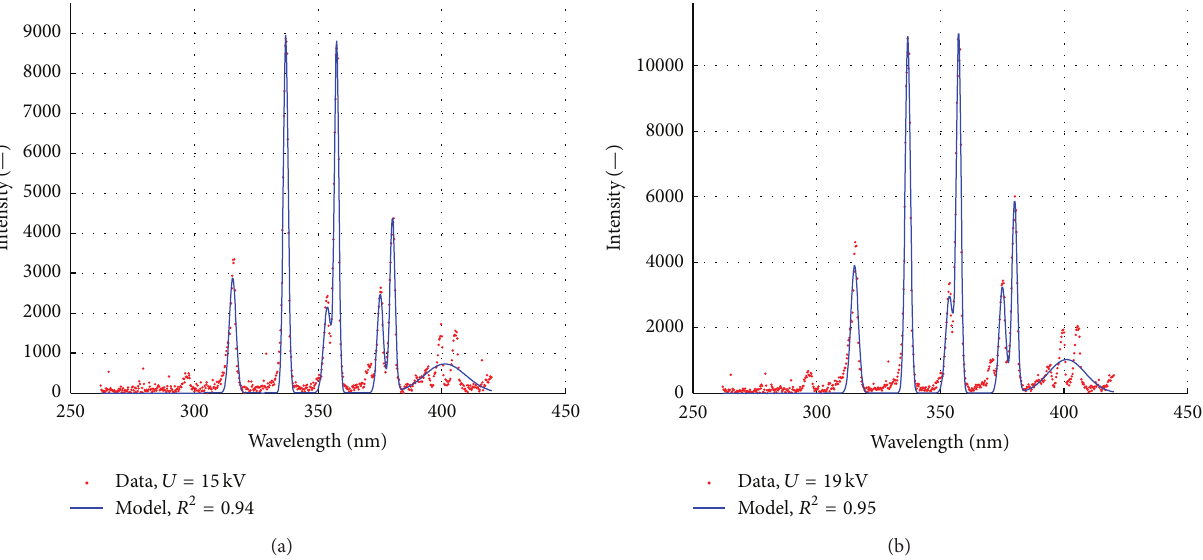
Figure 7: Intensity spectra of recorded and modeled light emission for selected values of PD generation voltages: (a) 0.75 𝑈 𝑝 = 15 kV and (b) 0.94 𝑈 𝑝 = 19 kV.